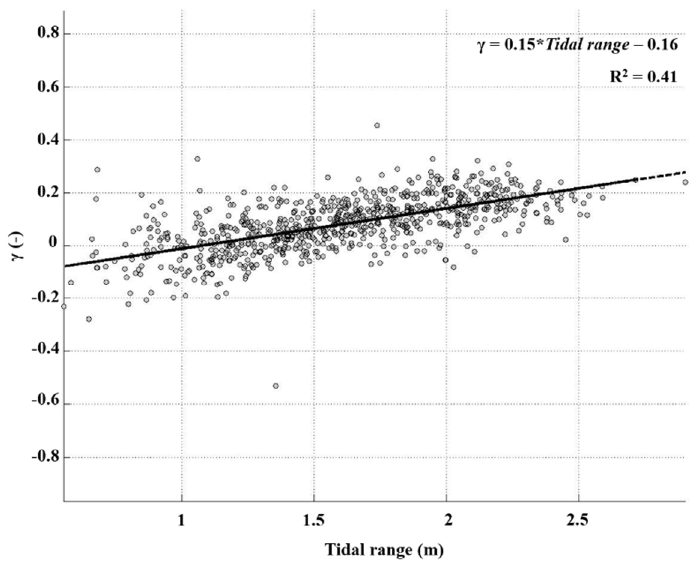
Figure 8. Tidal asymmetry index ( γ ) as a function of tidal range (m) at the study site. Black line corresponds to linear regression expressed by the equation y = 0.15x − 0.16 (R 2 = 0.41, n = 778, p < 0.001 with significance threshold at p = 0.05). Values of γ > 0 correspond to flood dominance, and values of γ < 0 correspond to ebb dominance.